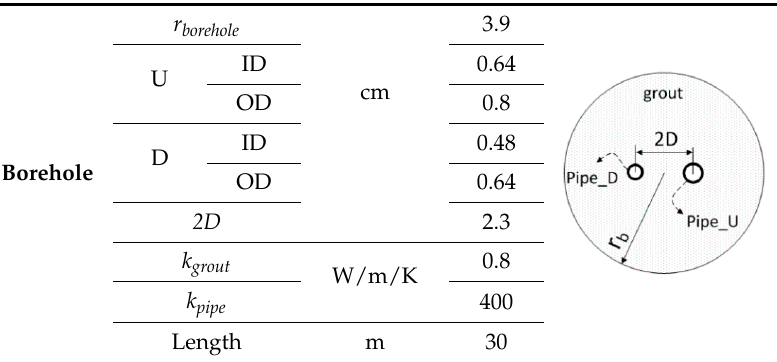
Table 2. Borehole dimensions.